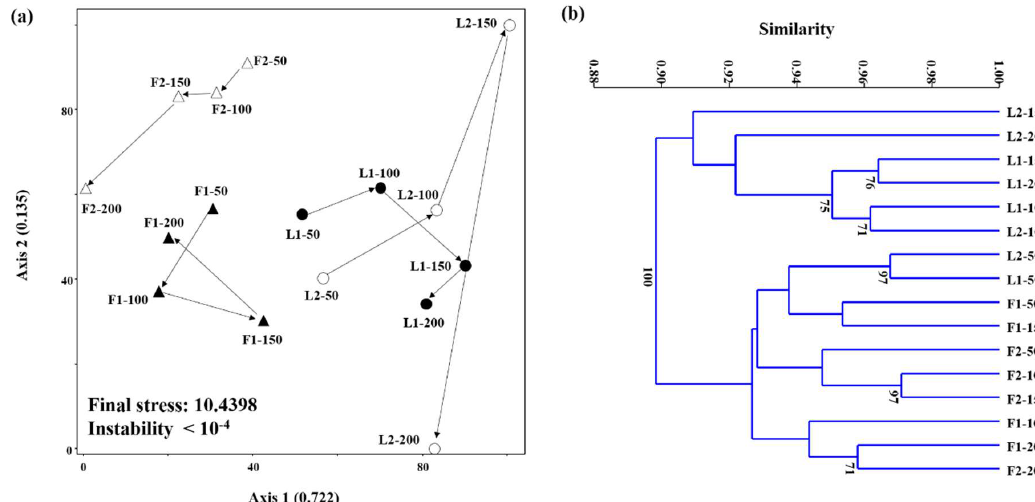
Figure 7. NMS plot ( a ) and cluster dendrogram ( b ) constructed based on the HRM peak profiles of bacterial 16S rRNA gene PCR products from residual Ulva biomass and filter biomass of R1 and R2. Data points are labeled with the corresponding sample types followed by WRRs (mL/d). Bootstrap values higher than 70% (1000 replicates) are shown.